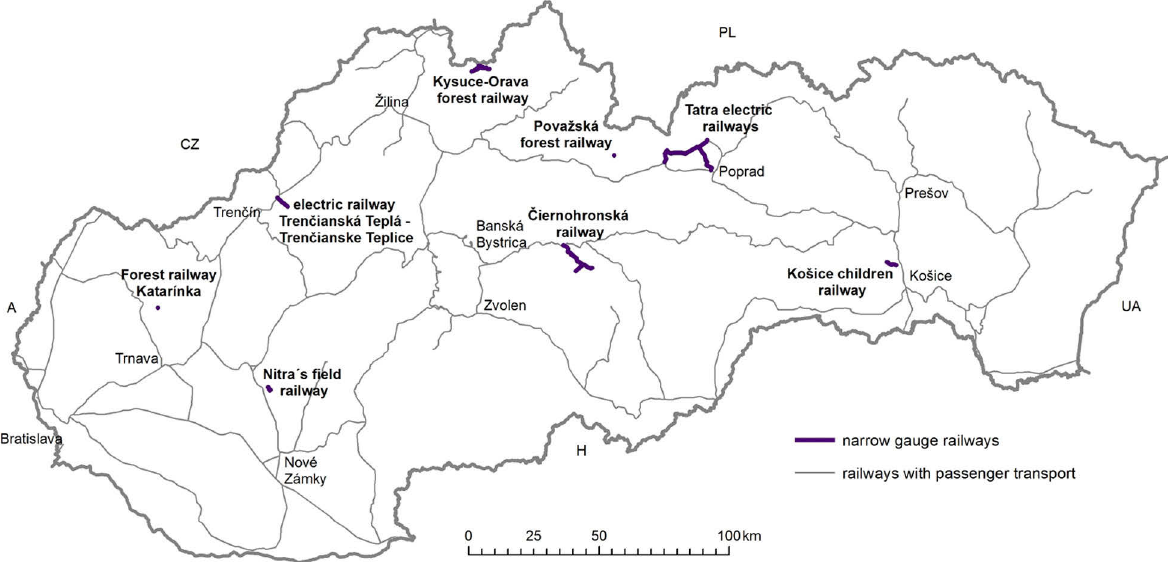
Fig. 8. Narrow-gauge railways in Slovakia. Source: own elaboration.